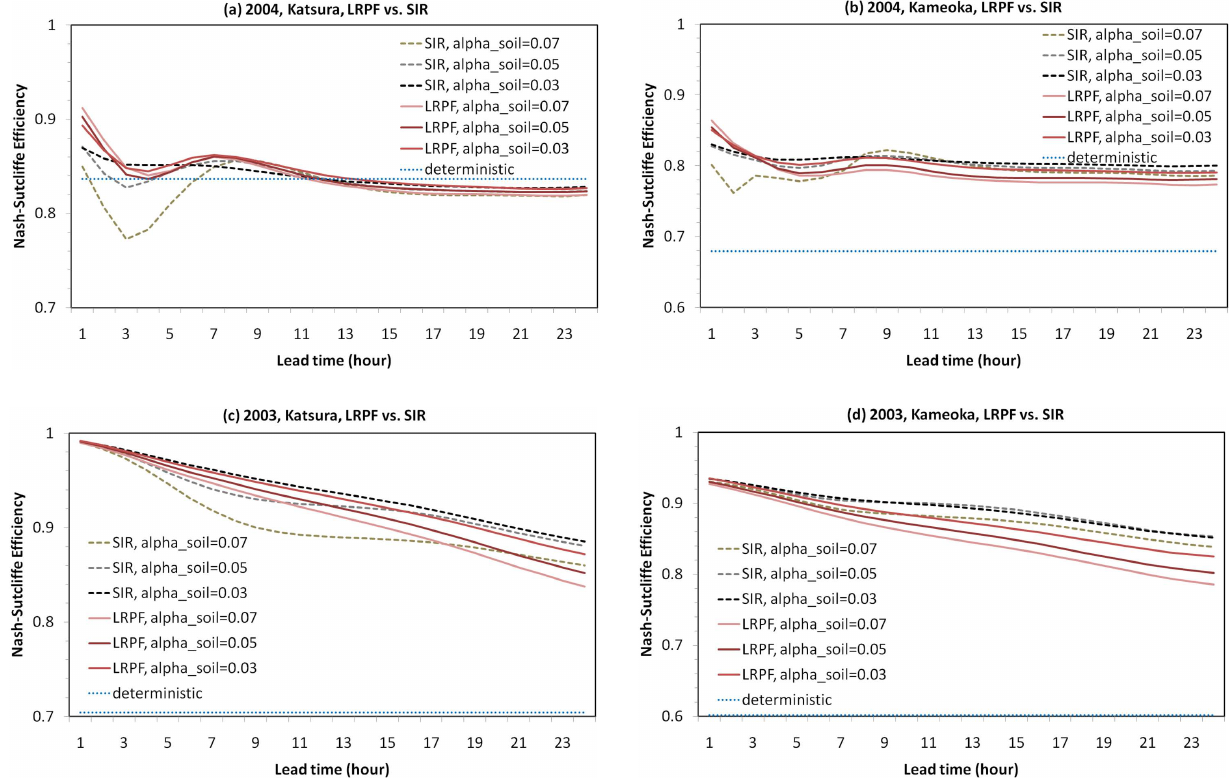
Fig. 13. Nash-Sutcliffe model efficiency for varying parameter values of the process error variance, α soil . The red lines represent the lagged regularized particle filter. The dashed lines represent the SIR particle filter. A dotted line represents a deterministic modelling case.